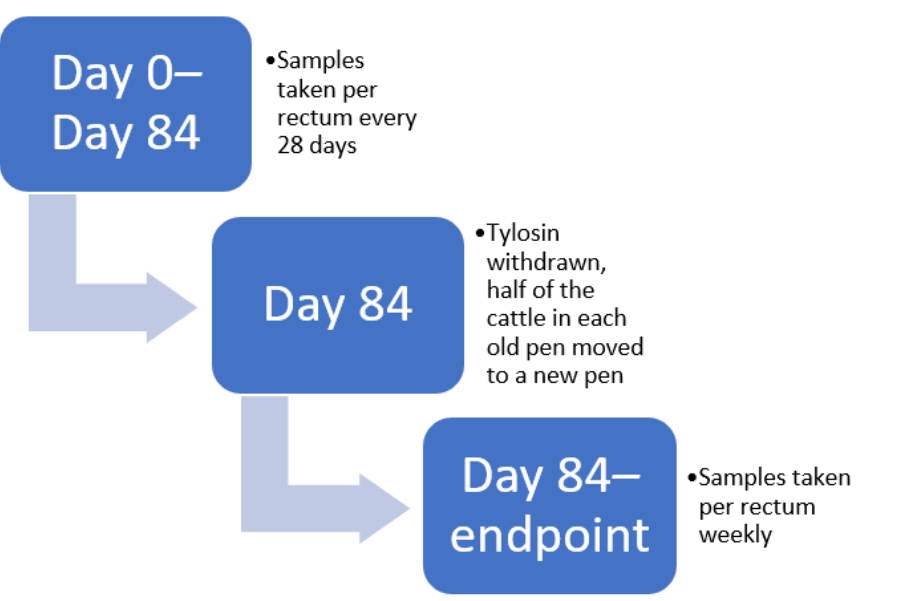
Figure 2. Timeline diagram of clinical stages of the study.